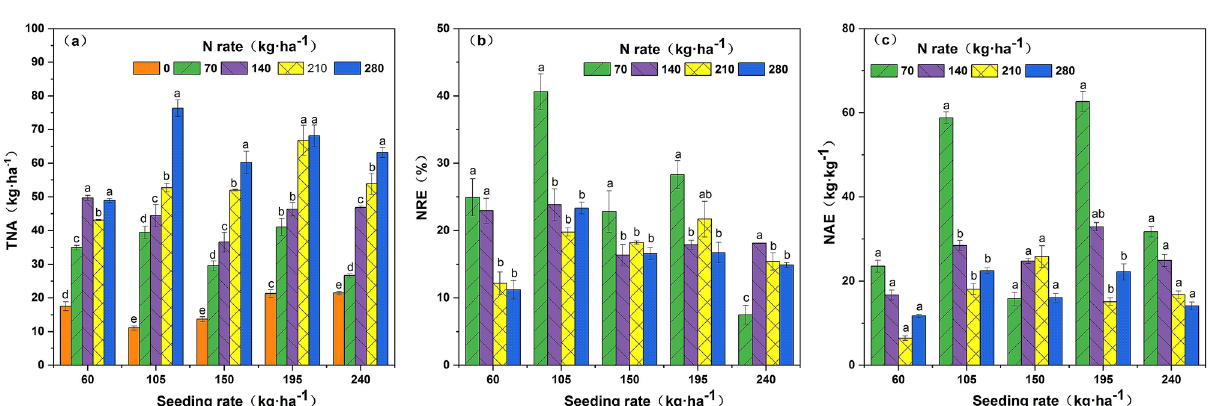
Figure 5. Effects of the interaction between seeding rate and nitrogen rate on nitrogen accumulation and nitrogen use efficiency of rice under dry cultivation. TNA total N accumulation, NRE N recovery efficiency, NAE N agronomic efficiency. Different letters with the same sowing amount indicate significant differences at P < 0.05. The figures were prepared and combined using Origin 2018 (www. origi nlab.